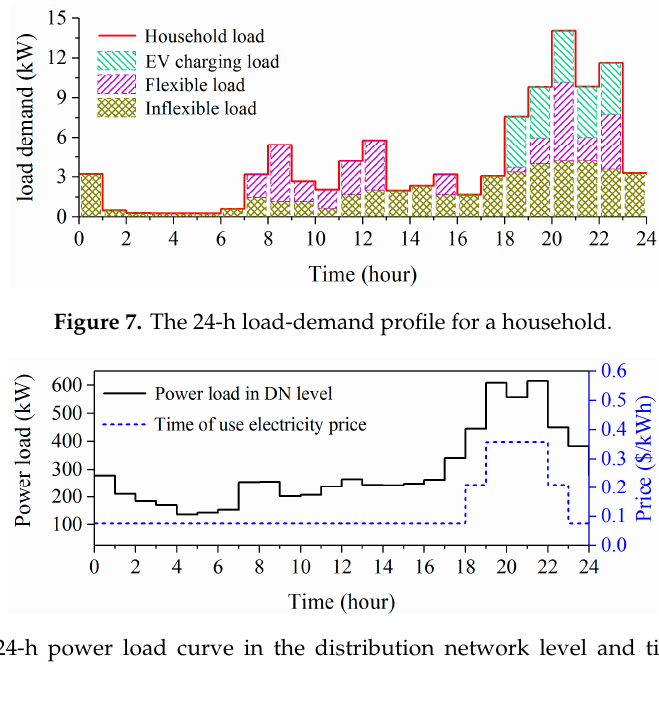
Figure 6. Modified IEEE-33 bus distribution system.